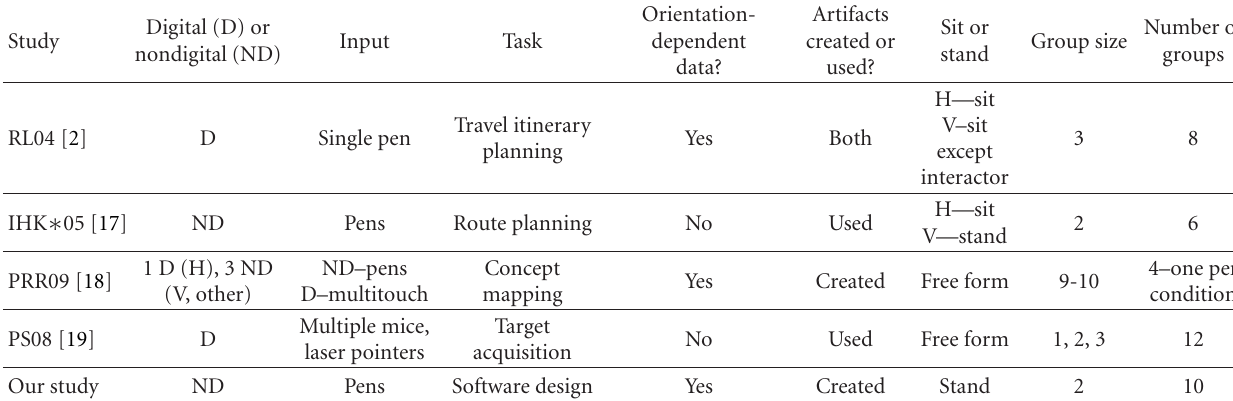
Table 1: Summary of horizontal and vertical display orientation studies (H: horizontal, V: